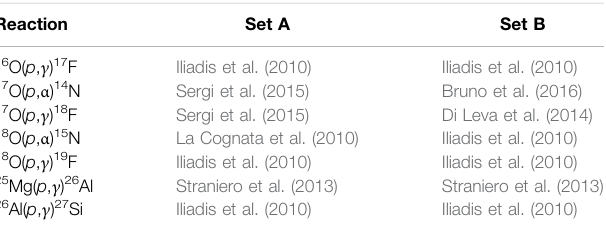
TABLE 1 | The 2 sets of reaction rates employed in our nucleosynthesis calculations.